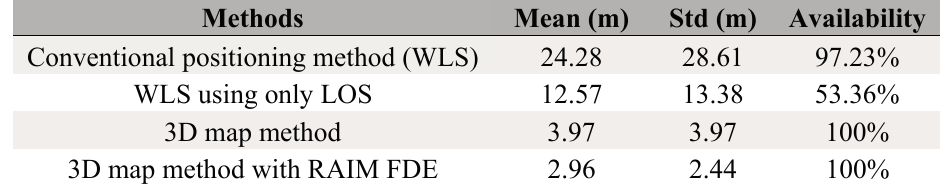
Figure 7. Results of the proposed 3D map positioning method before and after using the RAIM satellite selection method in a middle urban canyon. Table 3. Lateral positioning performance of the conventional method and the proposed 3D map method before and after using the RAIM method in the middle urban